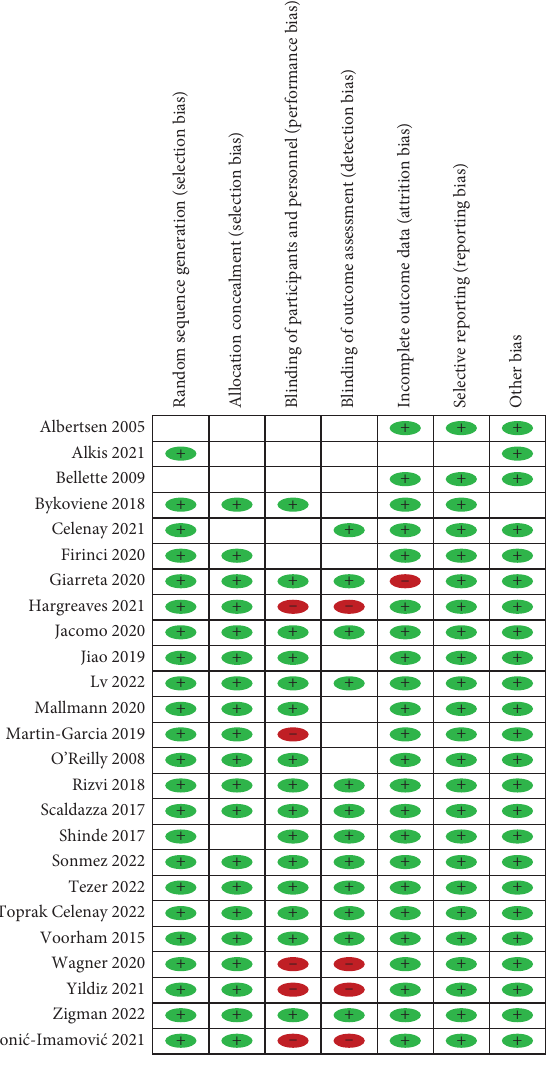
Figure 3: Risk of bias